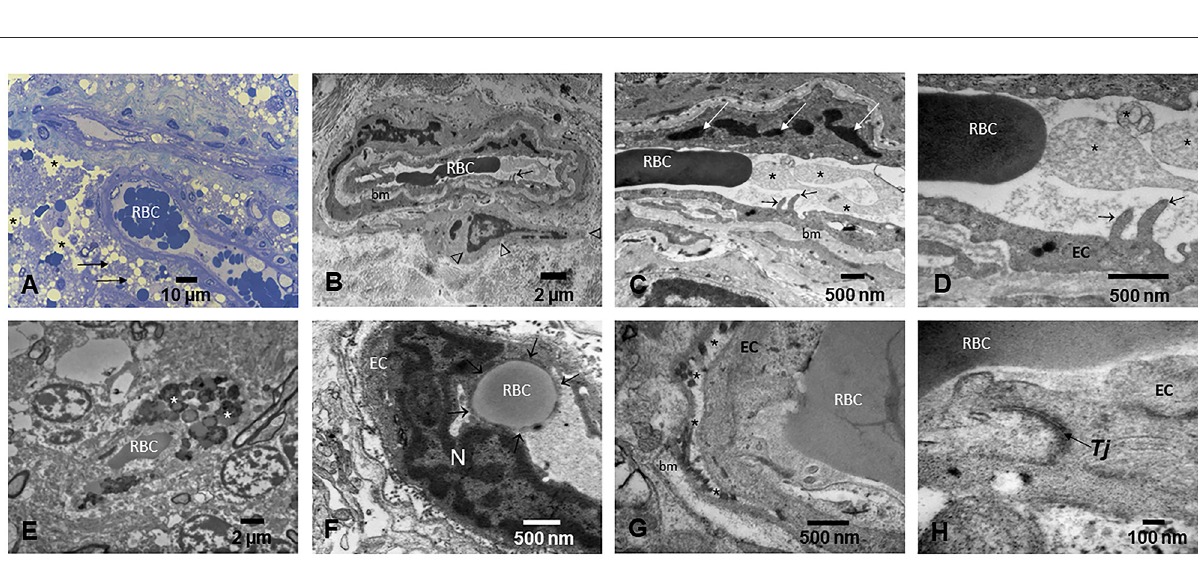
FIGURE6 Light and electron microscopy of the brain in different anatomical locations in MMC young residents. (A) Thirteen-year-old girl’s olfactory bulb showing small blood vessels with red blood cells (RBC) in the lumen and prominent endothelial cells. A significant number of perivascular vacuolated foamy cells (short arrows) and extensive areas of vacuolated neuropil (* ) are observed. (B) A frontal blood vessel showing two luminal RBCs and prominent endothelial extensions into the lumen (short arrow). The basement membrane (bm) is thickened, and a pericyte (arrow heads) is identified. (C) The activated endothelial cell sends filopodia into the lumen (short arrows), while the lumen is occupied by ghost cell fragments (*), seen in higher magnification in (D) . (E) Small frontal blood vessel containing one single luminal RBC and extravascular numerous lysosomal structures containing lipids and NPs (*). (F) Cerebellar blood vessel showing a typical RBC endothelial phagocytosis. The RBC is sequestered by the EC and surrounded by EC cytoplasm (short arrows). (G) Small blood cortical vessel with luminal RBCs closely in contact with the EC. The EC